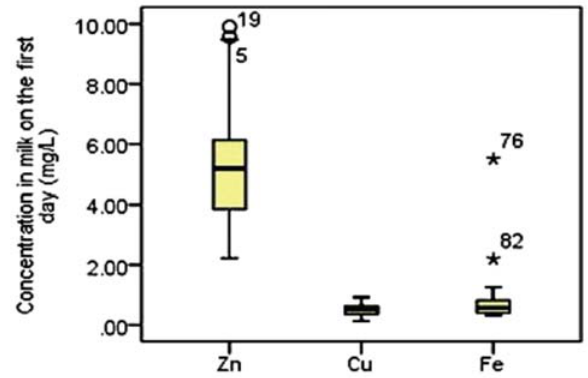
Figure 1. Concentration of Zn, Fe and Cu in human milk samples on a first day after the delivery. The boxes represent the median and the 25th and 75th percentiles; the whiskers represent the non-out- lier